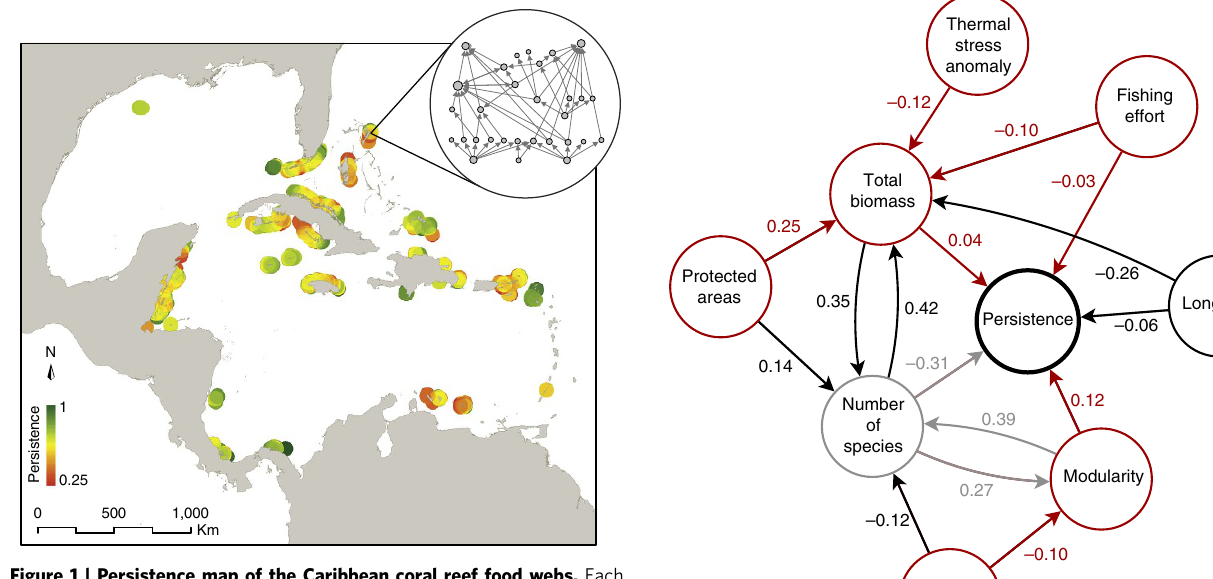
Figure 1 | Persistence map of the Caribbean coral reef food webs. Each point indicates a sampling site and the colour represents the average persistence value of its simulated food web. Red and green colours represent low and high persistence, respectively. This map was made creating a 50km buffer around each sampling site. The value of persistence of the sampling site is assigned to the area inside the buffer. Then, for representation purposes, each pixel in the map represents the average of the values of the buffers that overlap in that pixel. The insert shows one of the local food webs, where node size is proportional to its number of trophic interactions. 2 NATURE COMMUNICATIONS|7:10737|DOI: